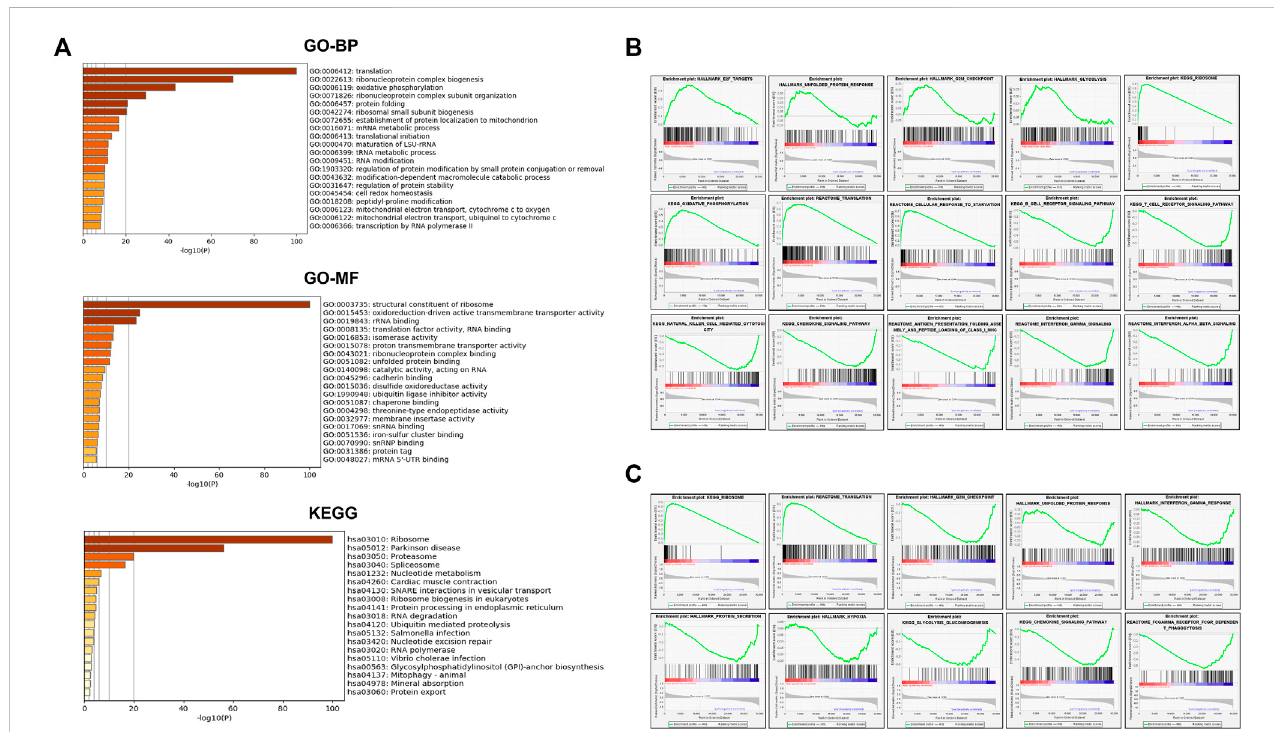
FIGURE 5 SEC61G-associatedgeneenrichmentanalysis. (A) Geneoncology(GO)-biologicalprocesses(BP),GO-molecularfunctions(MF)andKyotoencyclopedia of genes and genomes (KEGG) analysis of 1041 SEC61G positive co-expression genes in HNSCC (Head and Neck Squamous Cell Carcinoma (TCGA, Firehose Legacy)). (B) Enrichment plots derived from the gene set enrichment analysis (GSEA) related to high SEC61G expression in HPV-negative HNSCC based on TCGA-HNSC database. (C) GSEA related to high SEC61G expression in HPV-positive HNSCC based on TCGA-HNSC